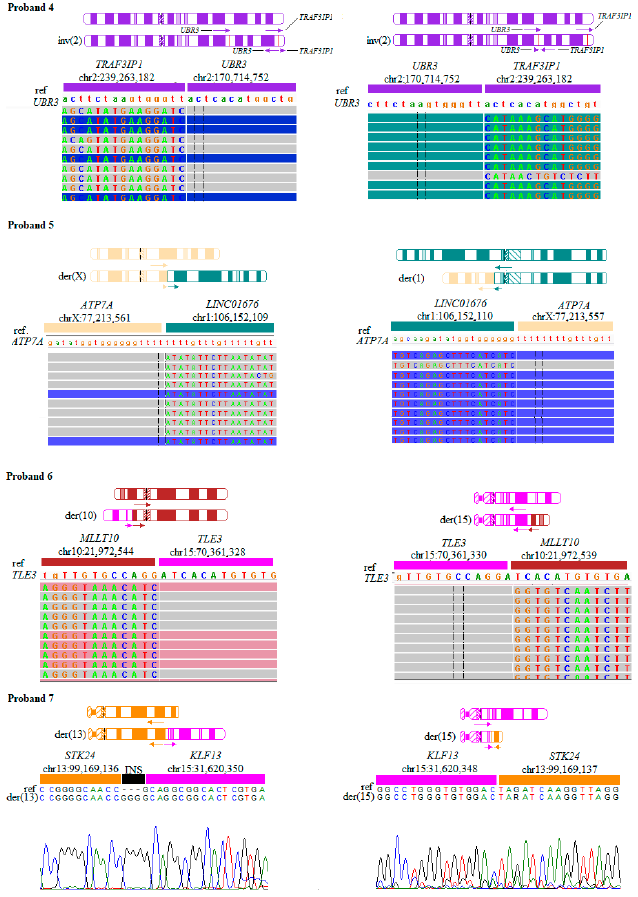
Figure 1. Results from Sanger sequencing and/or deep amplicon sequencing with NexteraXT library of the balanced chromosomal aberrations (BCAs) breakpoints. The figure for every patient includes: in the upper part, a schematically shown normal chromosome and below a chromosome containing the BCAs. Arrows indicate the orientation of the genes affected by translocation. The length of the arrows approximately corresponds to the length of the disrupted coding sequences. The lower part shows the sequencing results. For every BCA, both breakpoints are shown. In deep amplicon sequencing results, only split reads are shown (reads that present the exact structure of the breakpoint). One part of these reads fully maps to the reference genome, while the other part differs from the reference. In Proband 2 an inframe fusion gene might be created.